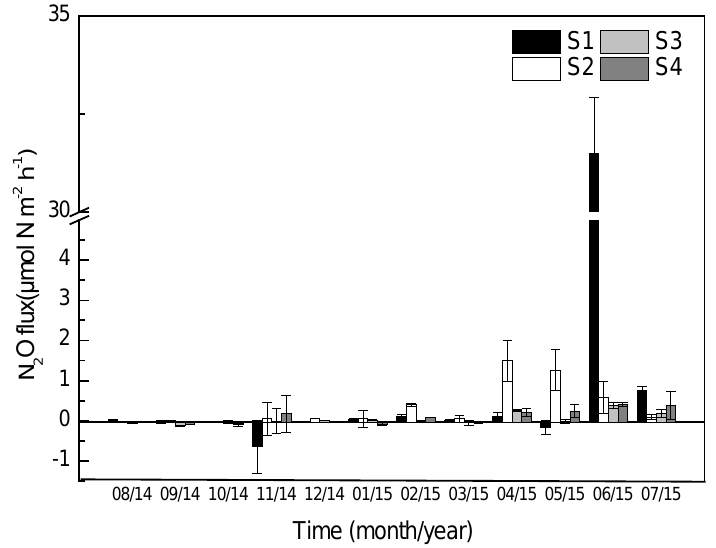
Figure 3. Monthly variations in the N 2 O flux at the sediment–water interface.